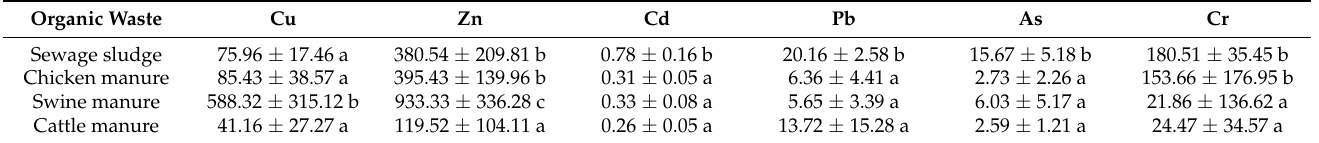
Table 2. Contents of heavy metals in sewage sludge and livestock manure (mg · kg − 1 ). Organic Waste Cu Sewage